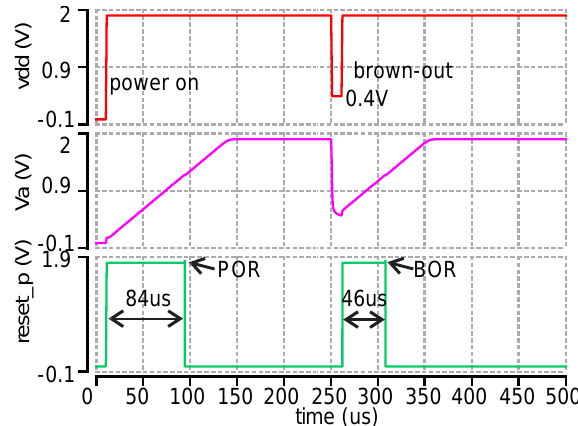
Figure 18. Post layout transient simulation results of the power-on-reset circuit.